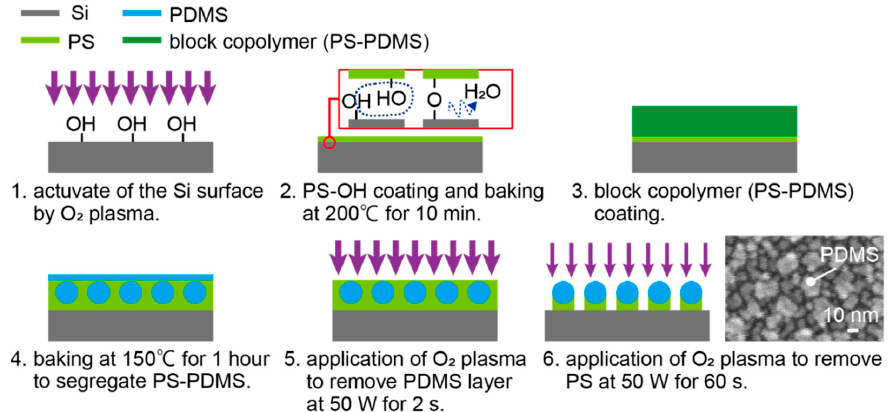
Figure 3. Patterning of nanosized dot templates on Si substrates using polystyrene–PDMS (PS- PDMS), a type of block